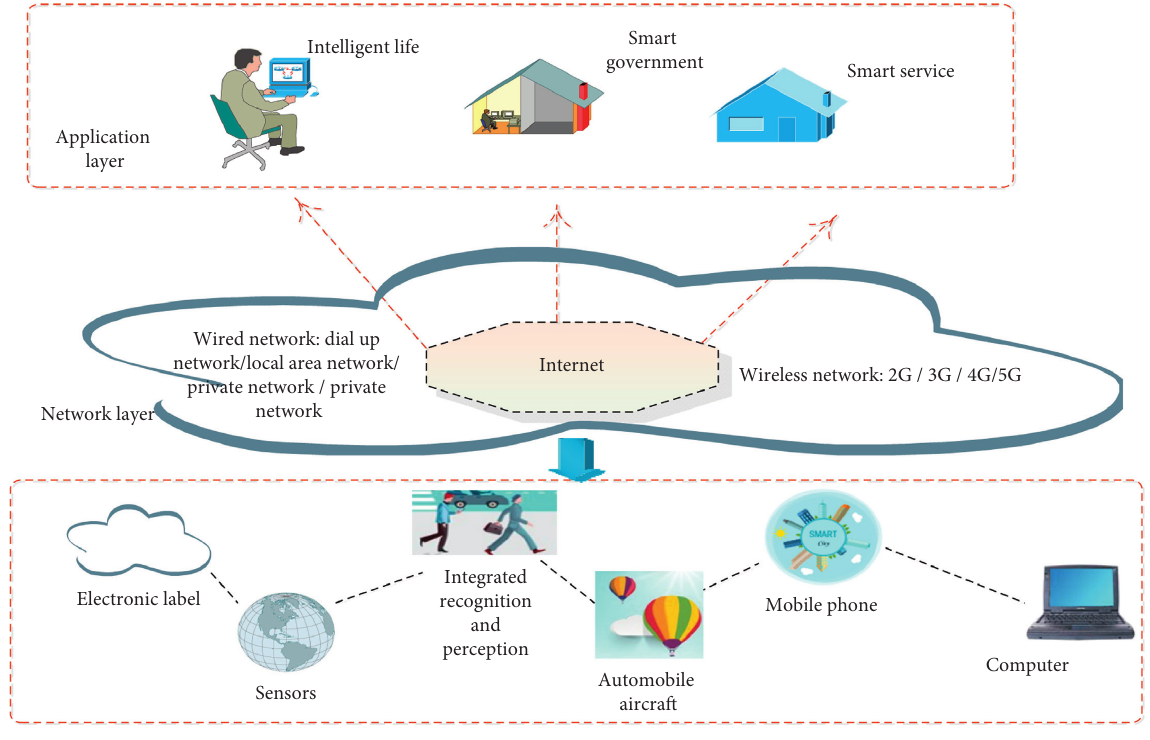
Figure 3: IoT-based construction